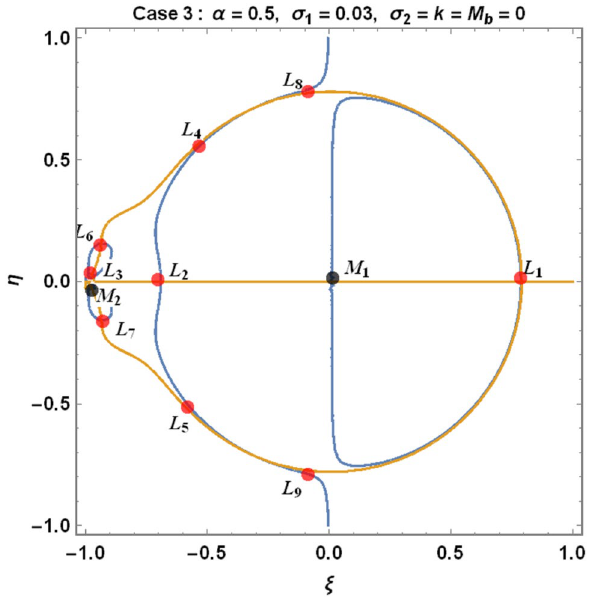
Figure 7. Effects of oblateness, Eccentricity of the orbits, semi-major axis, Albedo parameters, triaxiality, and the potential due to belt on the triangular libration points for the Earth–Moon system using case 3 of Table